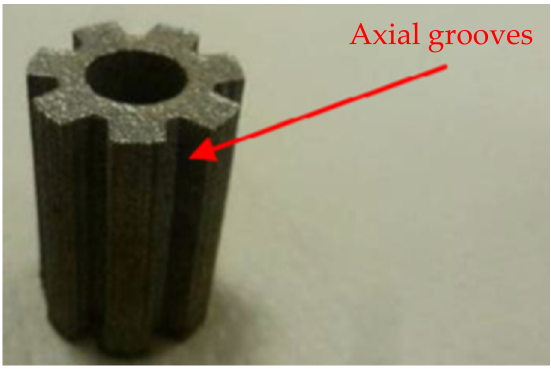
Figure 9. AM primary wick [8].